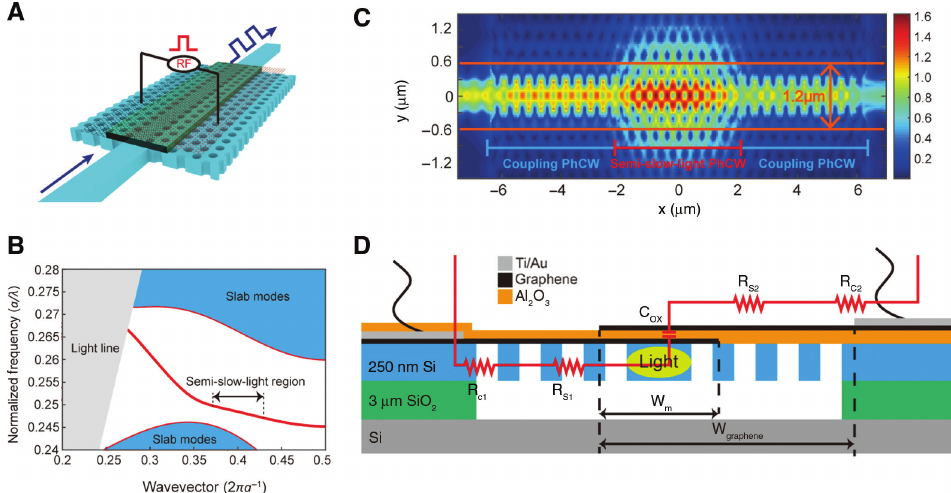
Figure 1: (A) Structure of the modulator. (B) Photonic band diagram of designed photonic crystal waveguide. (C) Electric field distribution of the PhCW. The PhCW consists of two coupling regions on each side and one semi-slow-light region in the center. The electric field extends to more than 1.2 μ m in the central part. (D) Cross section of the device with equivalent RC circuit. = 1.2 μ m for double-layer overlap width (not shown in The parameters are pitch = 390 nm and d = 193 nm for PhCW; W m